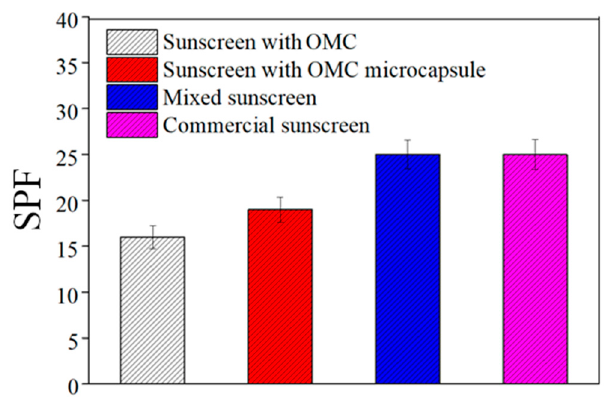
Figure 12. Comparison of SPF between microencapsulated sunscreen and various sunscreens.